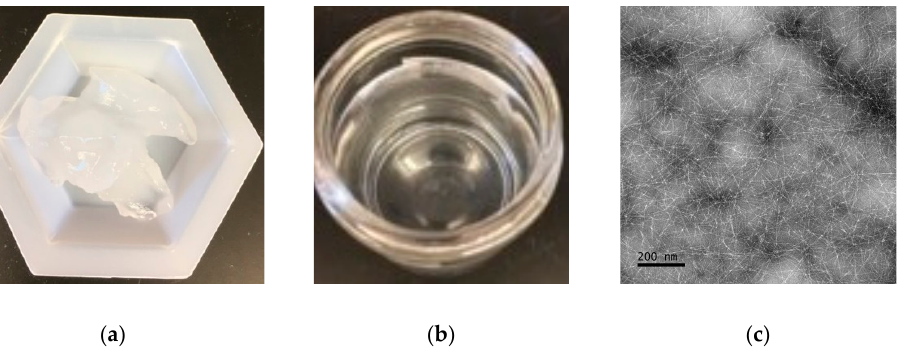
Figure 1. Macroscopic and microscopic images of TEMPO-CNF prepared from corn stover. ( a ) The as-prepared TEMPO-CNF concentrated gel; ( b ) 10-times diluted gel suspension after sonication; ( c ) TEM image of TEMPO-CNF.